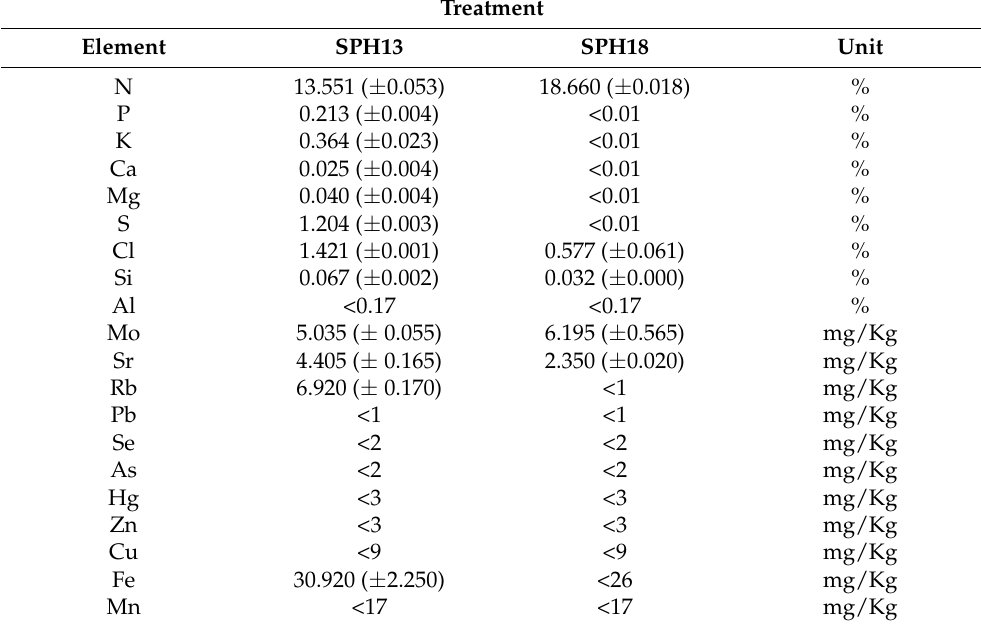
Table 2. Nutrient compositions of SPH13 and SPH18 ( n = 2, average ± the standard